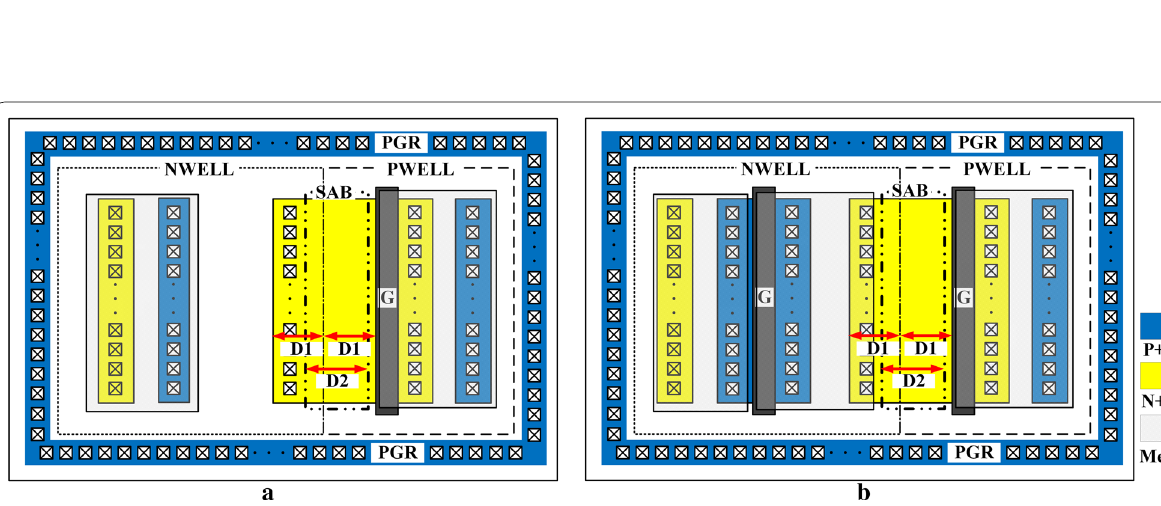
Fig. 4 Layout topologies of a the conventional LVTSCR and b the proposed